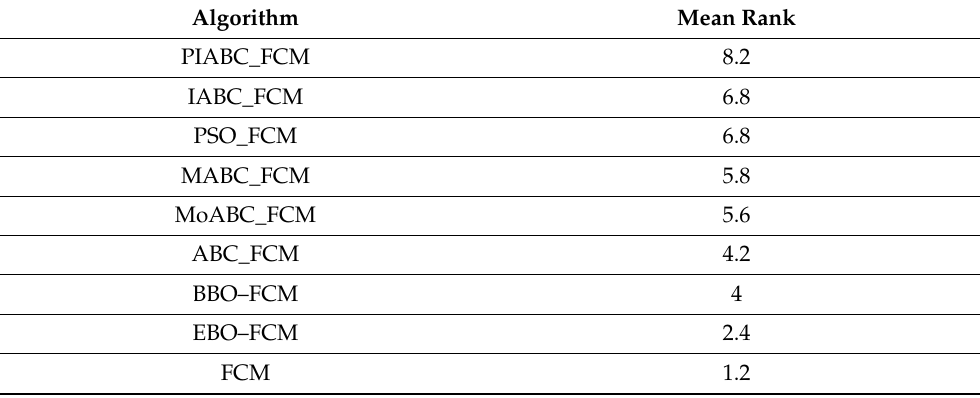
Table 10. Friedman Test based on S validity index—result for natural